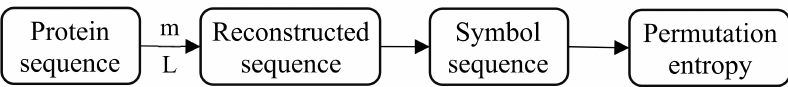
Figure 1. Calculation process of permutation entropy.